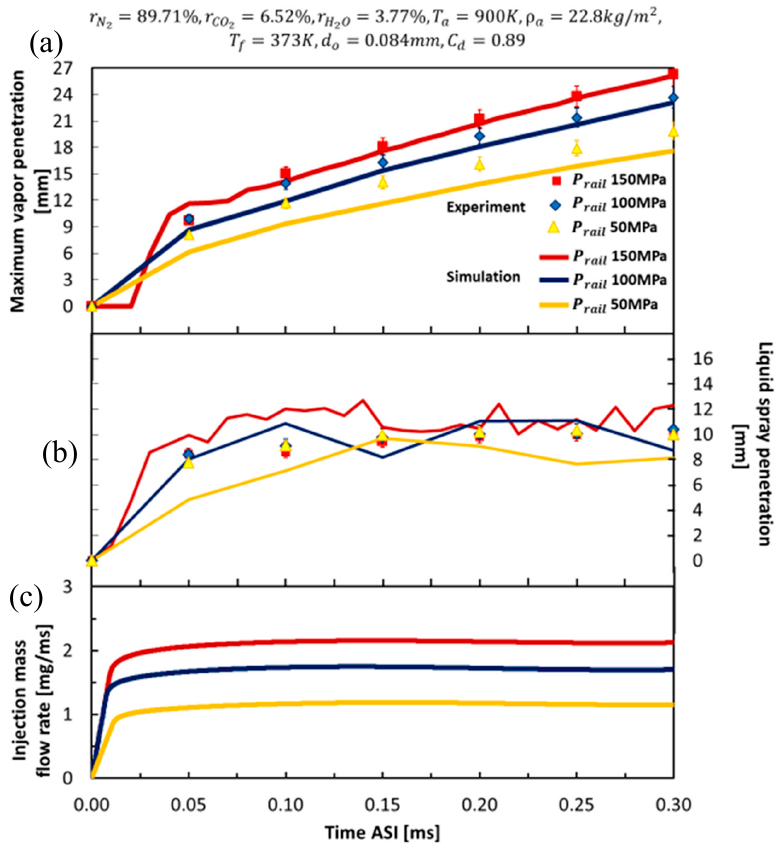
Figure 10. Comparison of the initial spray penetration (0.0–0.3 ms) for the experiment results [23] and the simulation results under different rail pressures. ( a ) Maximum vapor penetration, ( b ) liquid spray penetration and ( c ) injection mass flow rate.